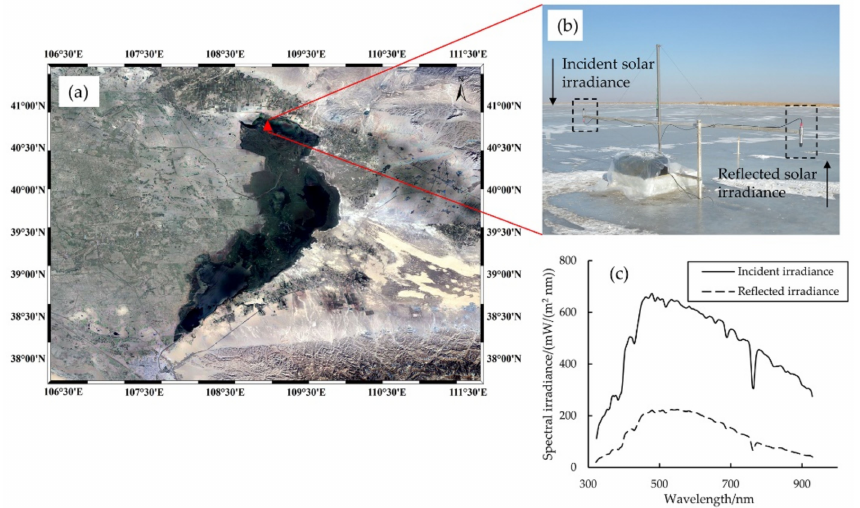
Figure 1. ( a ) Location of Wuliangsuhai Lake, ( b ) the Trios spectral irradiance sensors at the observa- tion site on the ice surface, and ( c ) the incident and reflected spectral irradiance measured at 12:00 on 22 January. The arrows in ( b ) indicate the incident directions of light to the